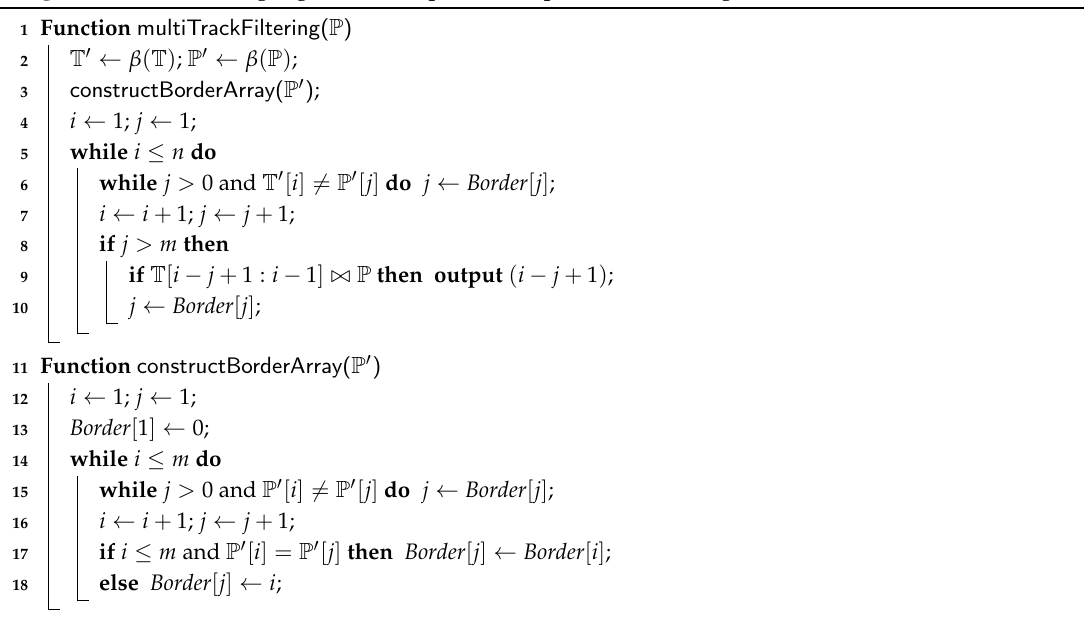
Algorithm 14: Filtering algorithm for permuted pattern